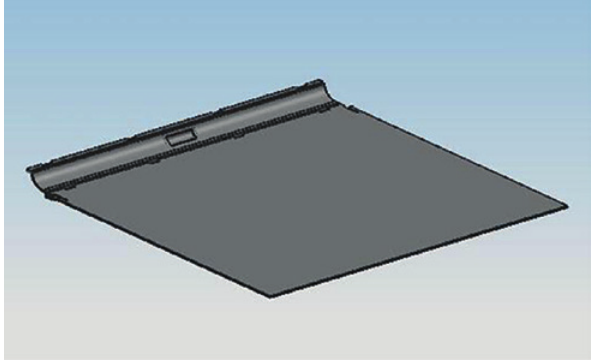
Figure 1: The thin-walled